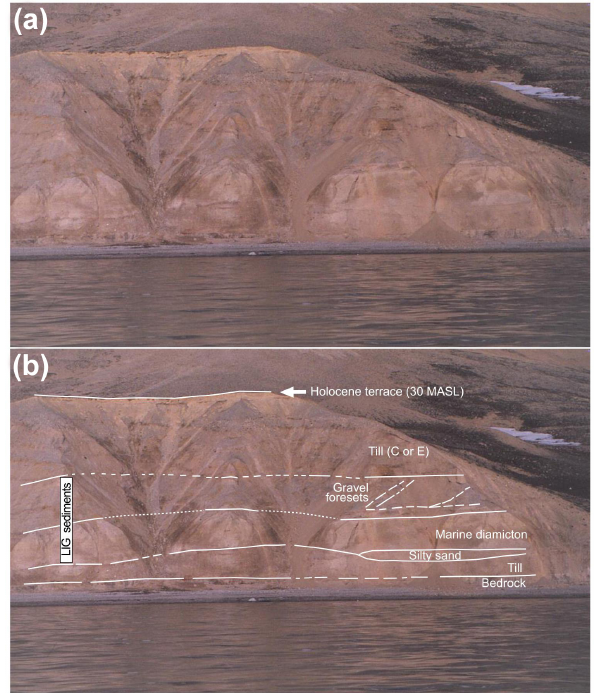
Figure 9. Photograph of Sect. II at Kapp Ekholm, Svalbard. Panel (a) is the original photograph, and panel (b) shows stratigraphic units. Solid white line indicates a confirmed stratigraphic contact; dashed line indicates inferred stratigraphic contact (largely due to sediment slumping). The LIG sediments (indicated by the white text box) are about 10m in thickness. Most Mytilus edulis were found in the lower part of the marine diamicton. Photo Jan Mangerud, 1988.